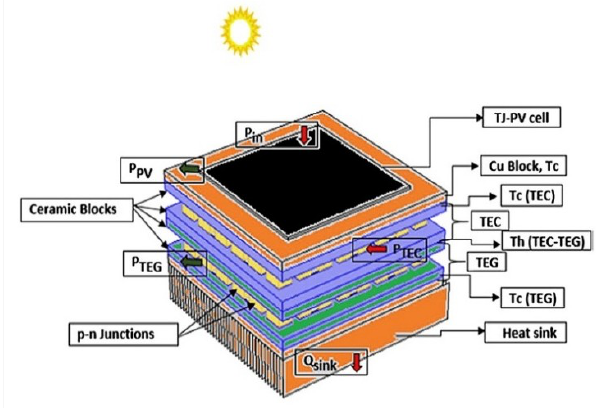
Figure 25. COMSOL MULTIPHYSICS’s photovoltaic-thermoelectric (PV-TE) hybrid system model [42].